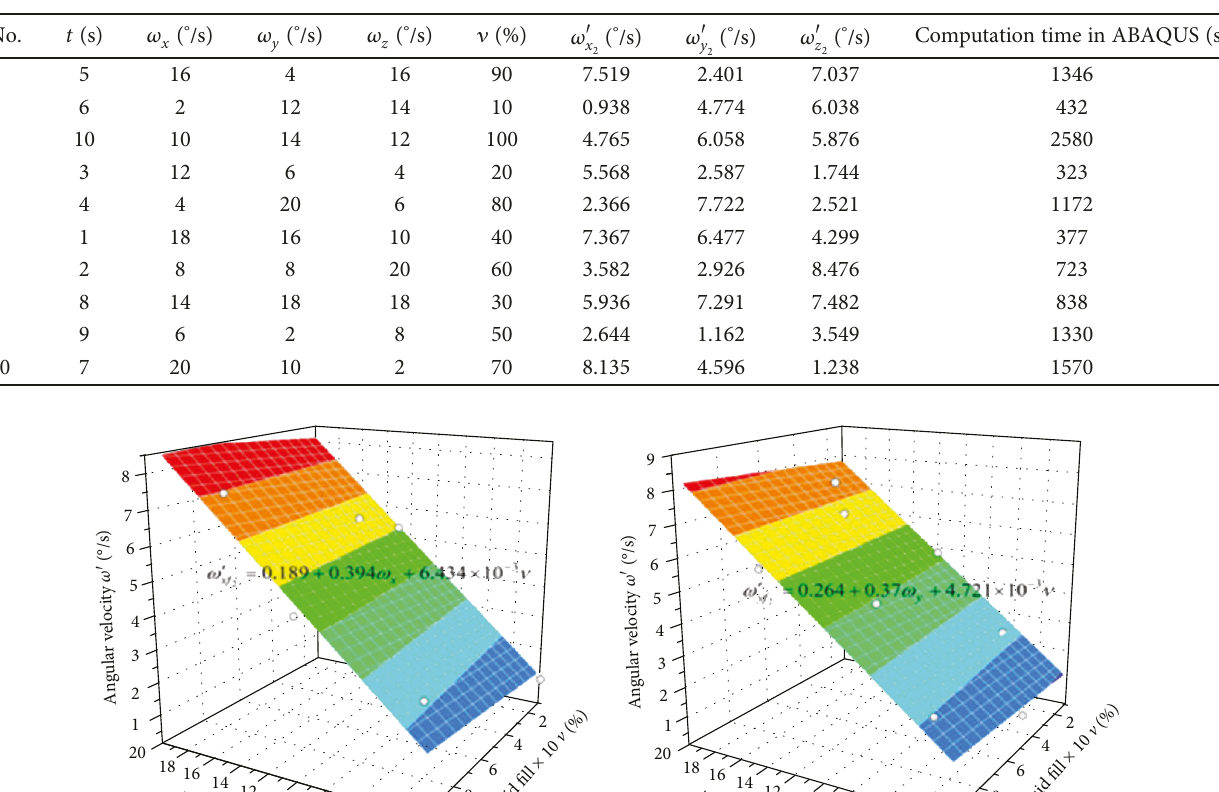
Table 10: Simulation results of liquid storage tank.